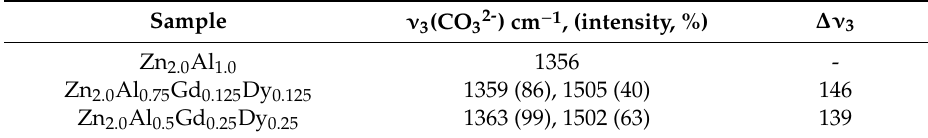
Table 3. Position of the bands assigned to the ν 3 stretching modes of the carbonate anion.